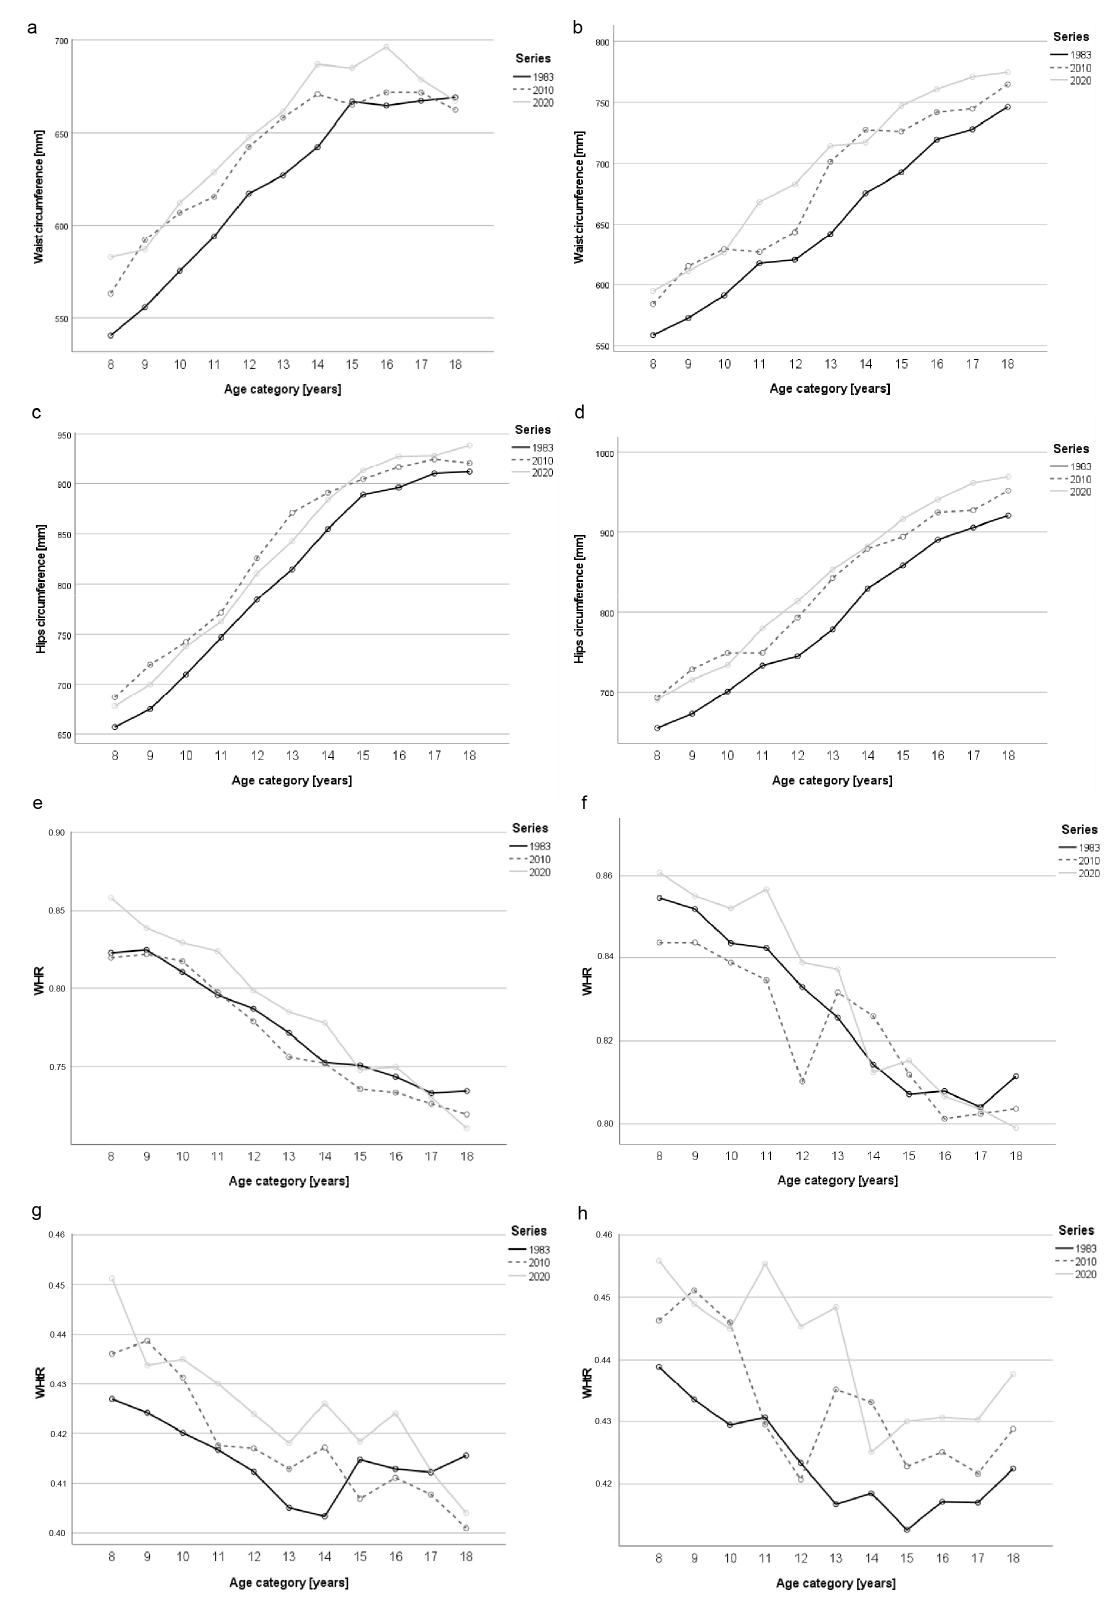
Figure 1. Changes in waist circumference (( a )—girls, ( b )—boys), hips circumference (( c )—girls, ( d )—boys), WHR (( e )—girls, ( f )—boys), and WHtR (( g )—girls, ( h )—boys) between the analyzed